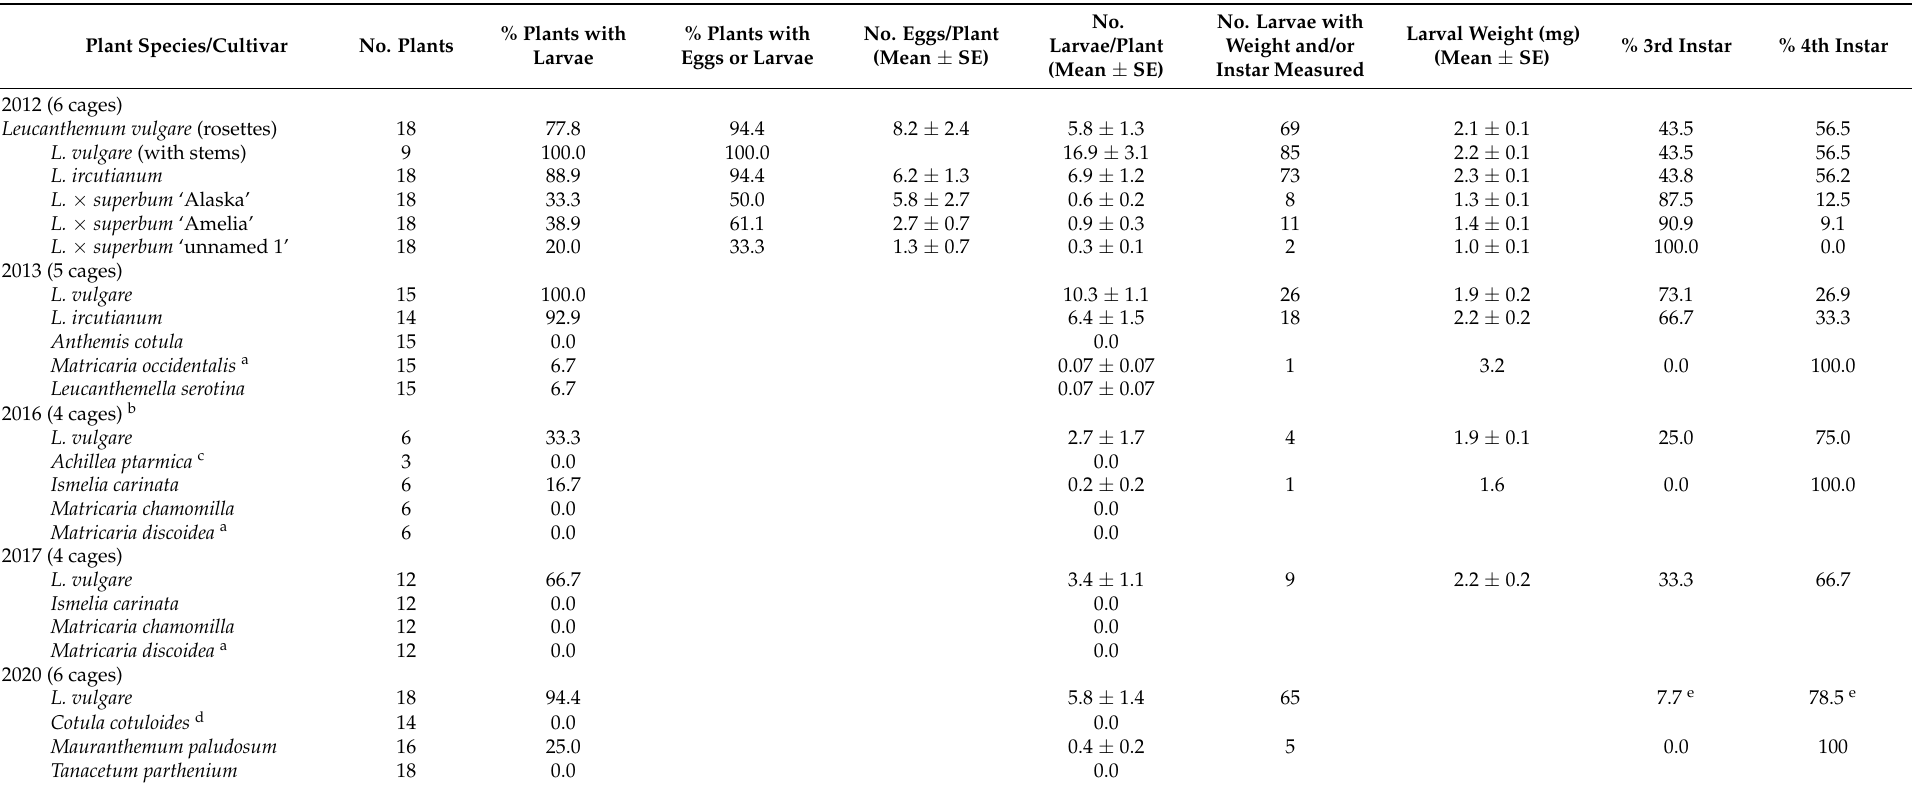
Table 2. Results of multiple-choice field cage tests conducted in 2012, 2013, 2016, 2017 and 2020. Six to twelve egg-laying females of Dichrorampha aeratana were released in each of the cages. Most Leucanthemum vulgare and L. ircutianum plants were in the rosette stage, while many of the non-target plants were already bolting or flowering. Plant Species/Cultivar 2012 (6 cages) Leucanthemum vulgare